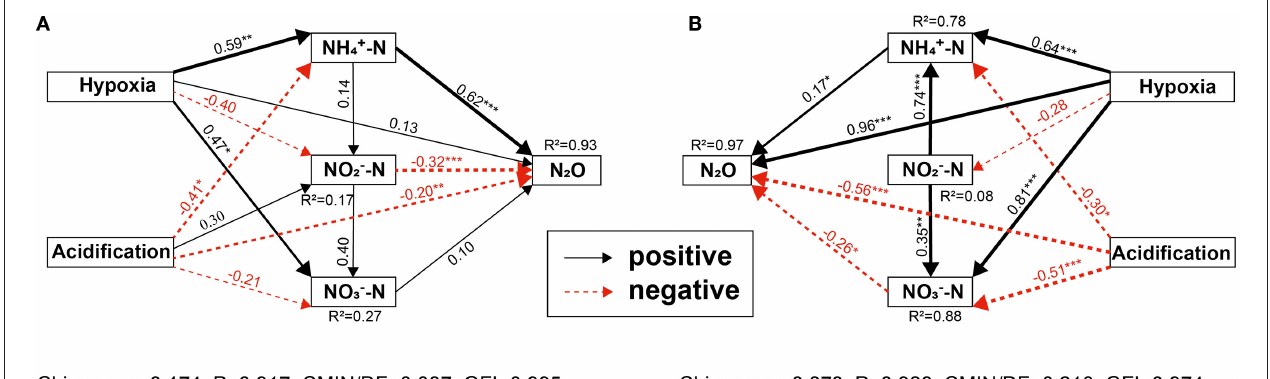
FIGURE 7 | (A,B) SEM analysis examining the effects of ocean acidification and hypoxia on N 2 O potential production for (A) Dongjiang port; (B) Hongxing watrf. Solid black and red arrows indicate significant positive and negative effects, and gray lines indicate non-significant coefficients paths. *, **, and ***indicate significance levels at p < 0.05, p < 0.01, and p < 0.001, respectively. R 2 -values associated with response variables represent the proportion of variation explained by the relationship with other variables. Values associated with arrows represent standardized path coefficients.